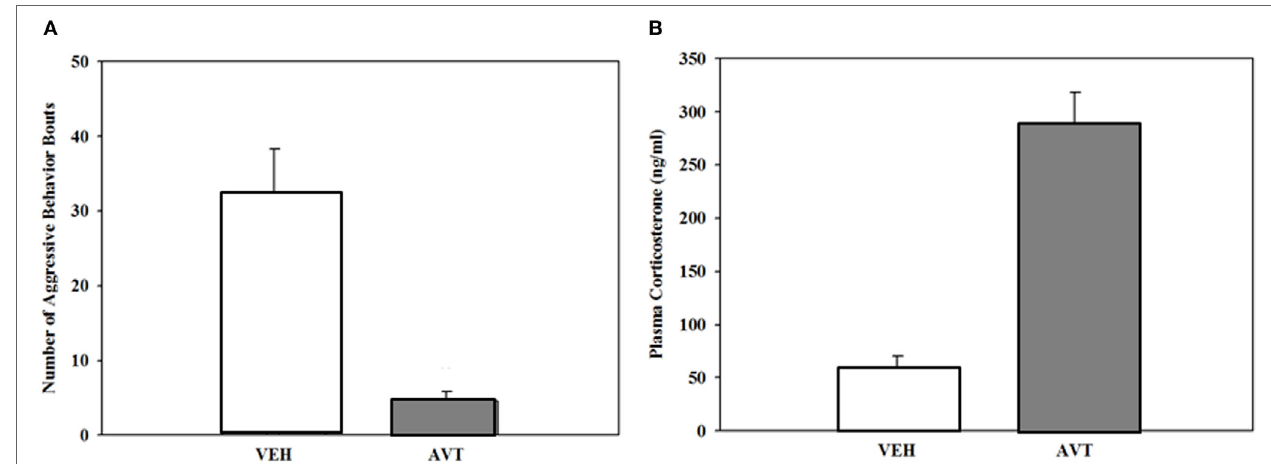
FiGURe 4 | (A) . Reduction in aggressive responses (mean + SEM) to a mirror in male green anoles following intraperitoneal injection of arginine vasotocin (AVT) (15 µg AVT/50 μ l reptile Ringer; N = 10) or vehicle ( N = 6). (B) . Increase in plasma corticosterone in the same animals following treatment (mean + SEM). From data in Dunham and Wilczynski